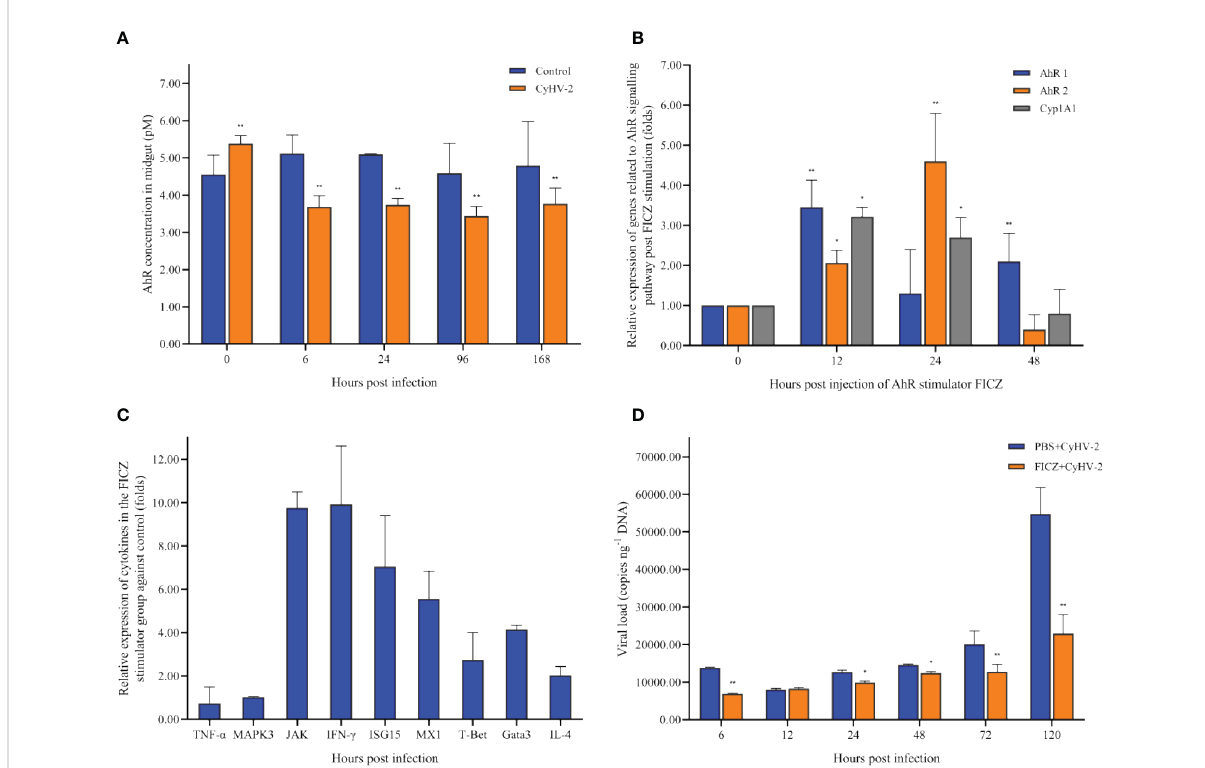
FIGURE 8 Time-dependent changes of the aryl hydrocarbon receptor (AhR) concentration in the midgut of fi sh post-CyHV-2 infection (A) , the effect of 6- Formylindolo[3,2-b]carbazole (FICZ) on the AhR signaling pathway (B) , the effect of FICZ on the transcription of cytokines (C) , and effect of FICZ on the viral replication in vivo (D) . All measurements are done in the midgut. * means a signi fi cant difference between two groups at a p -value from 0.01 to 0.05. ** means a p -value less than